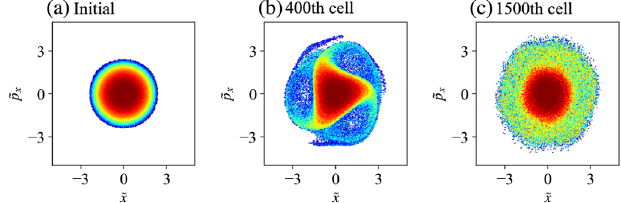
11. Horizontal phase-space configurations of a waterbag beam observed at (a) the transport entrance, (b) 400th FD cell, and (c) 1500th FD cell. The initial rms tune depression is chosen to be η ¼ 0 . 8 . The operating point is set at ν 0 x ¼ ν 0 y ¼ 0 . 192 where the coherent sextupole ( m ¼ 3 ) parametric resonance is expected from Eq. (3).